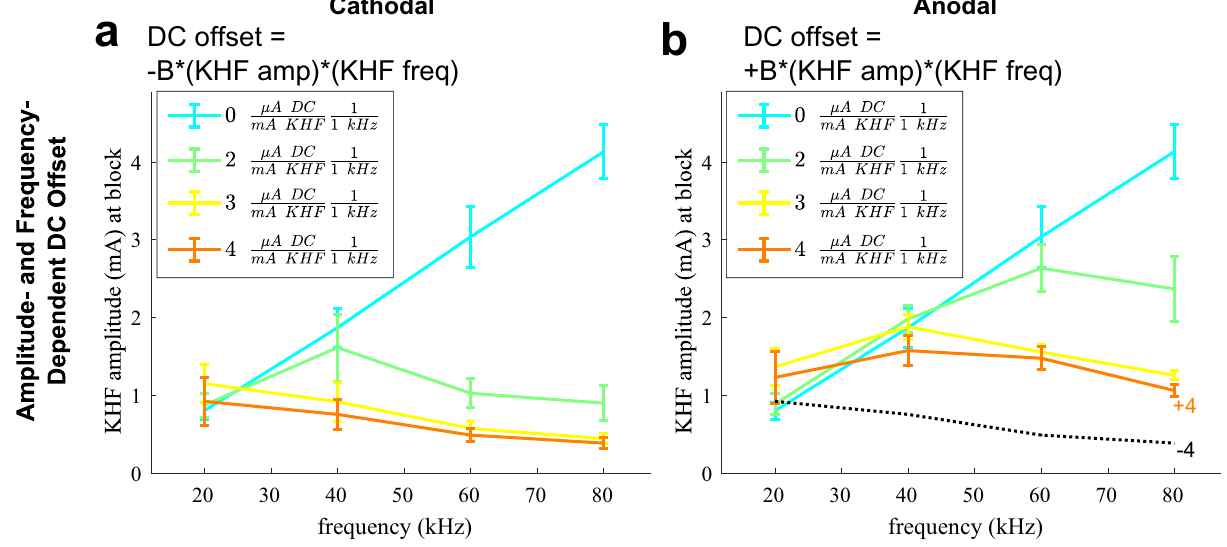
Figure 4. Frequency effects on block thresholds during in vivo rat tibial nerve experiments. Symmetric KHF rectangular waves were offset by cathodal ( a ) or anodal ( b ) DC that scaled with KHF amplitude and frequency. Plots show mean and standard error of the mean of block thresholds across three to seven nerves. The black dotted line on the anodal DC offset plot shows the − 4 μA per mA KHF per 1 kHz data from the cathodal DC offsets plot. See Supplemental Fig. 1 for individual nerve data